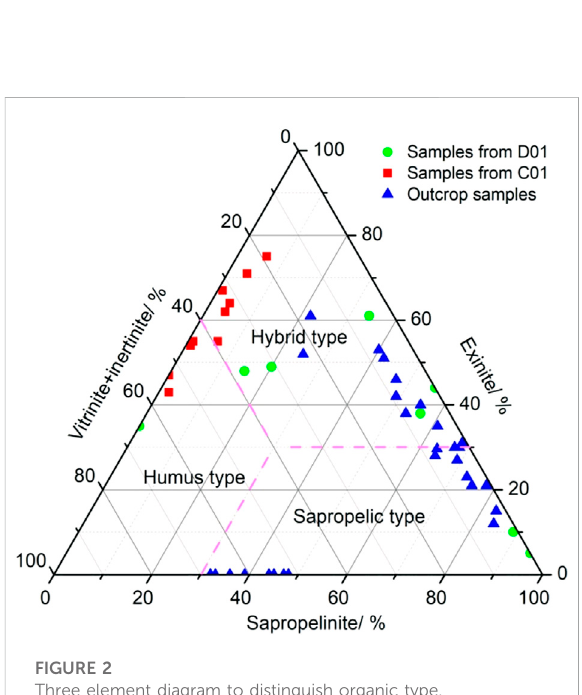
FIGURE 2 Three element diagram to distinguish organic